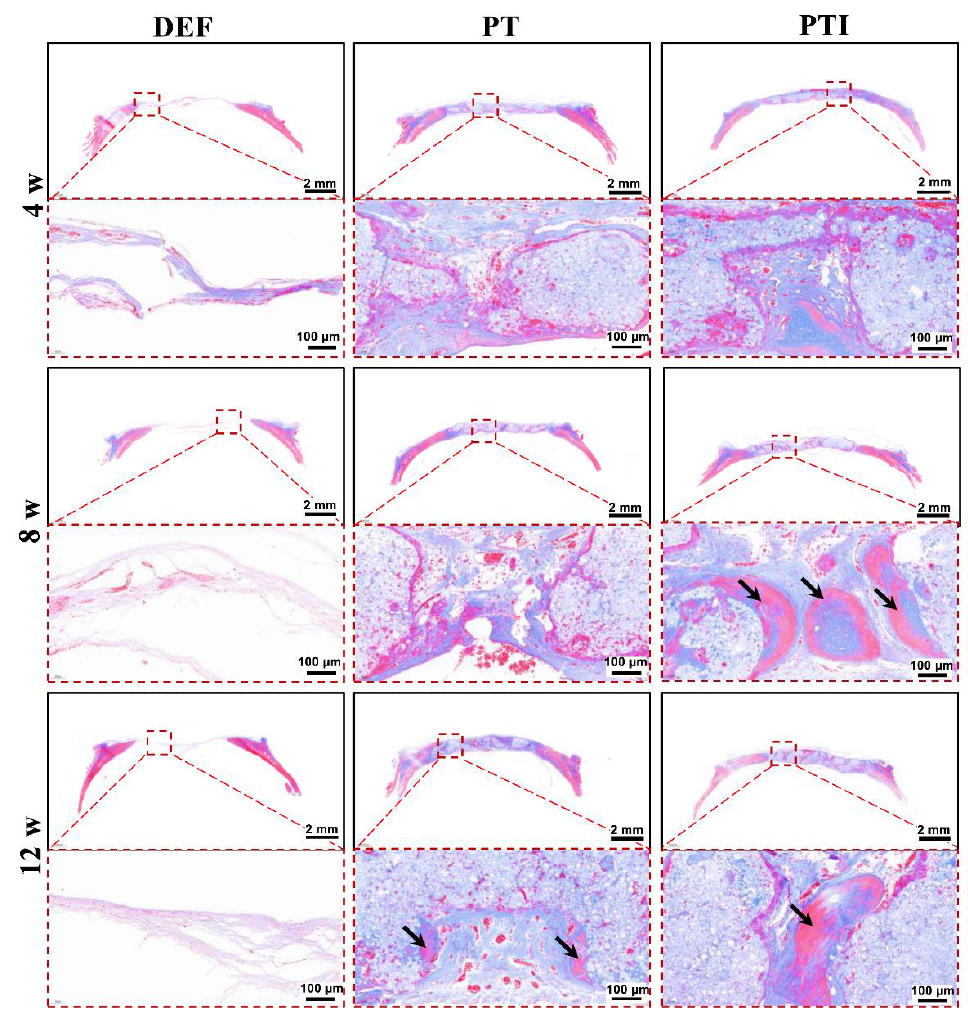
Figure 13. Microscopic appearance of tissue sections after MT staining; the arrows indicate new bone.